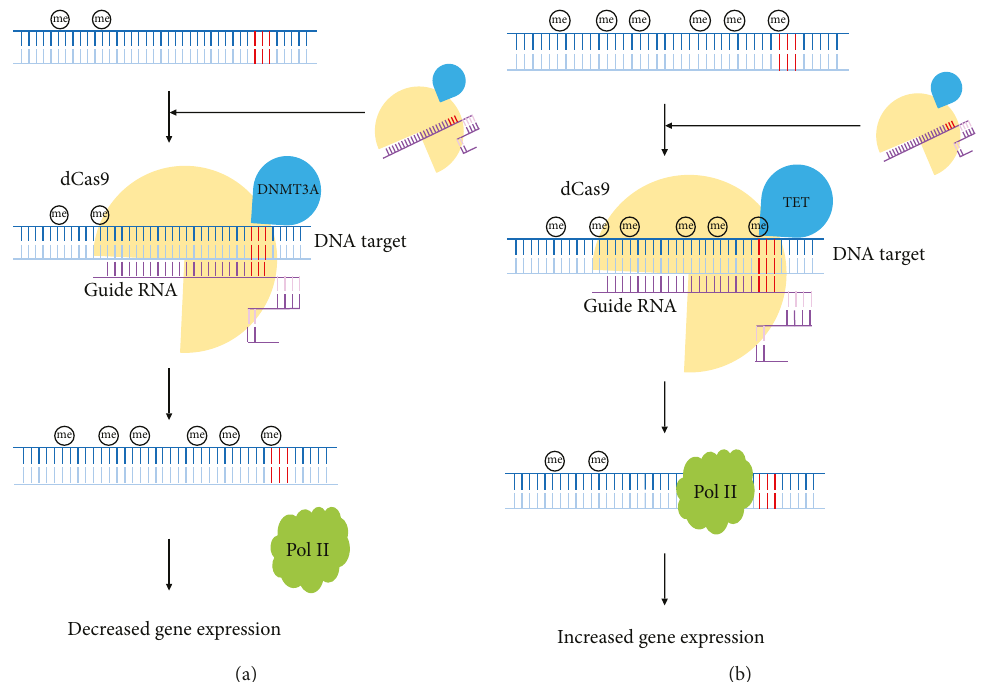
Figure 1: DNA methylation and demethylation mediated by Cas9. DNA sequences are represented by the blue lines. PAM sequences are highlighted by red color. Guide RNA sequences are shown in purple color. DNA polymerase II (PoI II) is represented by the green irregular shape. The circled “ me ” represents methylation at a speci fi c CpG site. Basically, dCas9 functions as a DNA-binding protein. DNMT3A or TET is the epie ff ector. The dCas9-epie ff ector complex is guided to the DNA target by guide RNA via Watson-Crick base pairing to execute (a) DNA methylation or (b) demethylation, thus inducing decreased or increased gene